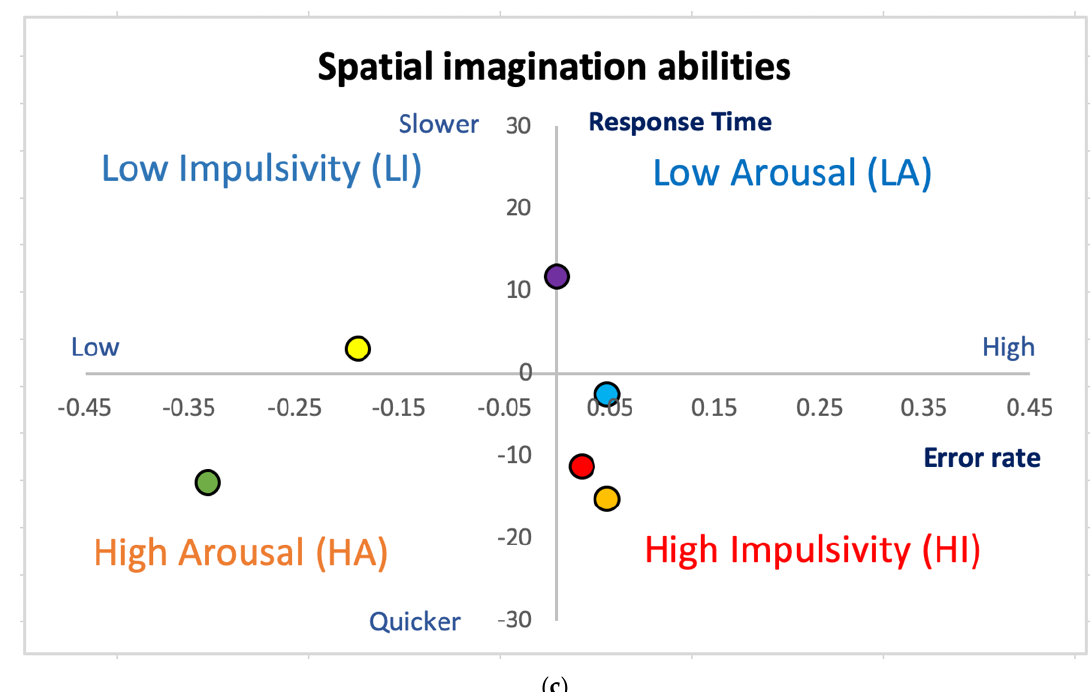
Figure 5. ( a ) Response time of participants’ performance in spatial imagination abilities by background colours; ( b ) Error rate of participants’ performance in spatial imagination abilities by background colours; ( c ) Colour impacts on spatial imagination abilities visualised in the Error-Speed space. The bars represent mean changes, while the error bars are the standard error of the mean across individual participants.